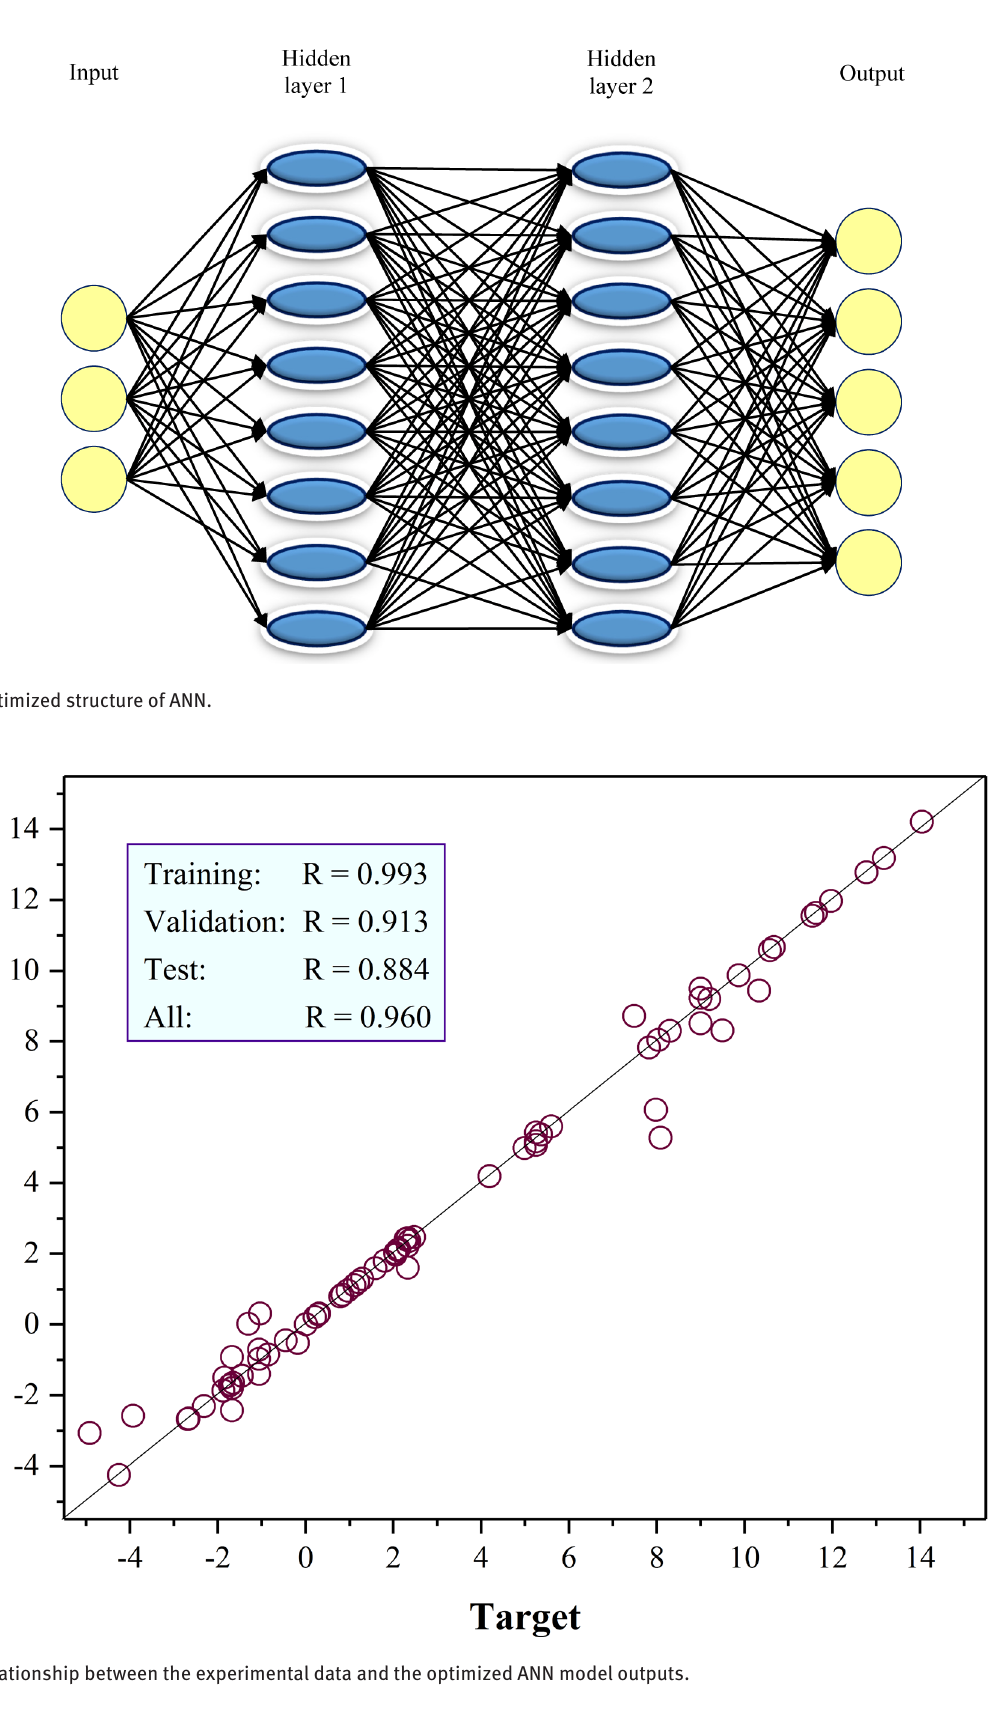
Figure 5: Relationship between the experimental data and the optimized ANN model